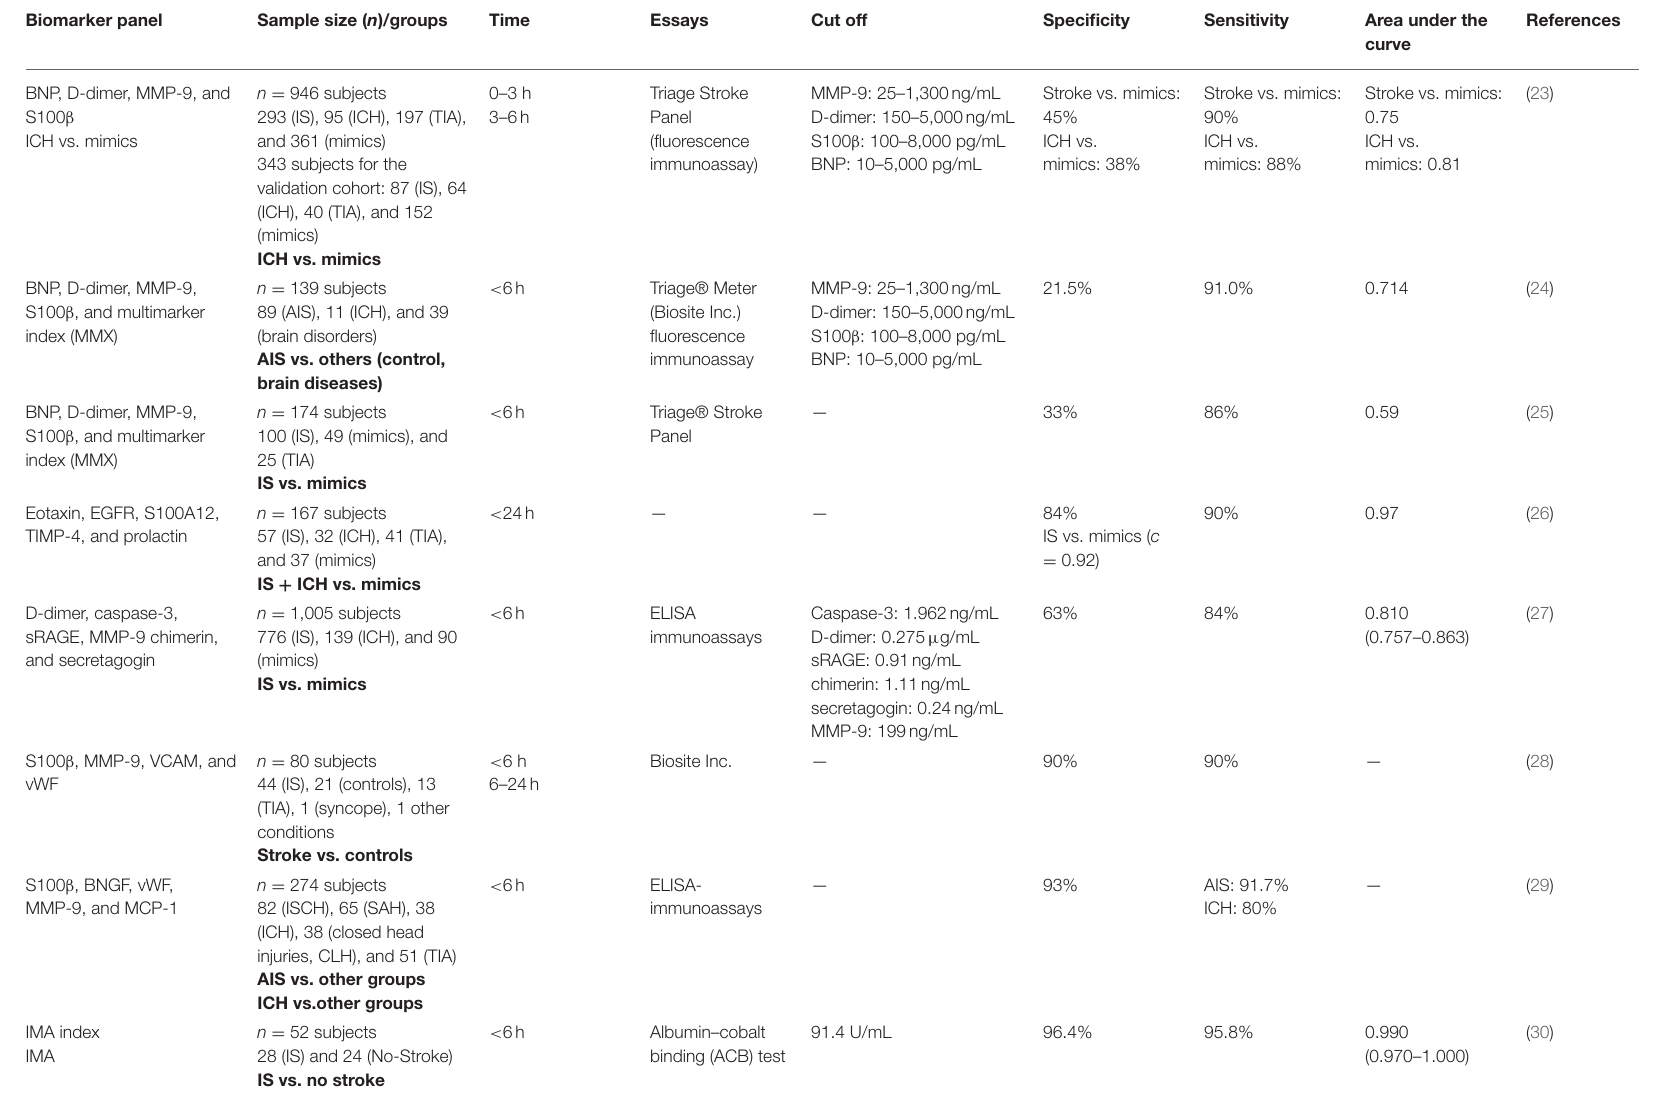
TABLE 1 | Summary of the 12 articles included in the systematic review. Biomarker